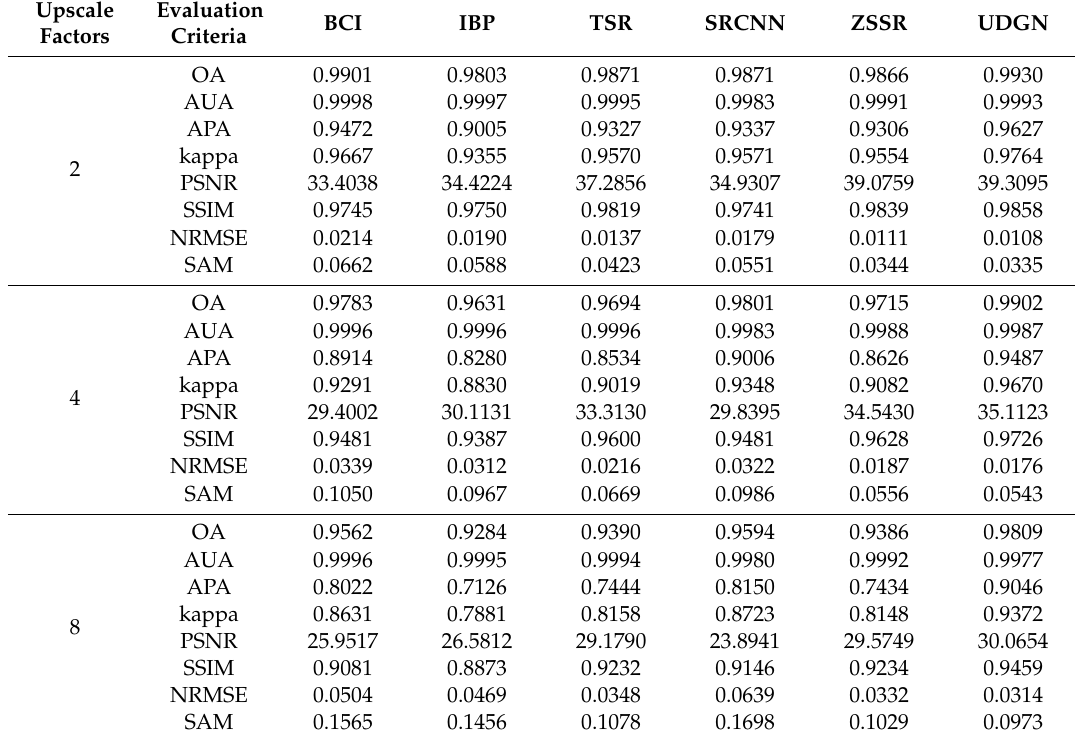
Table 4. Comparison results of di ff erent